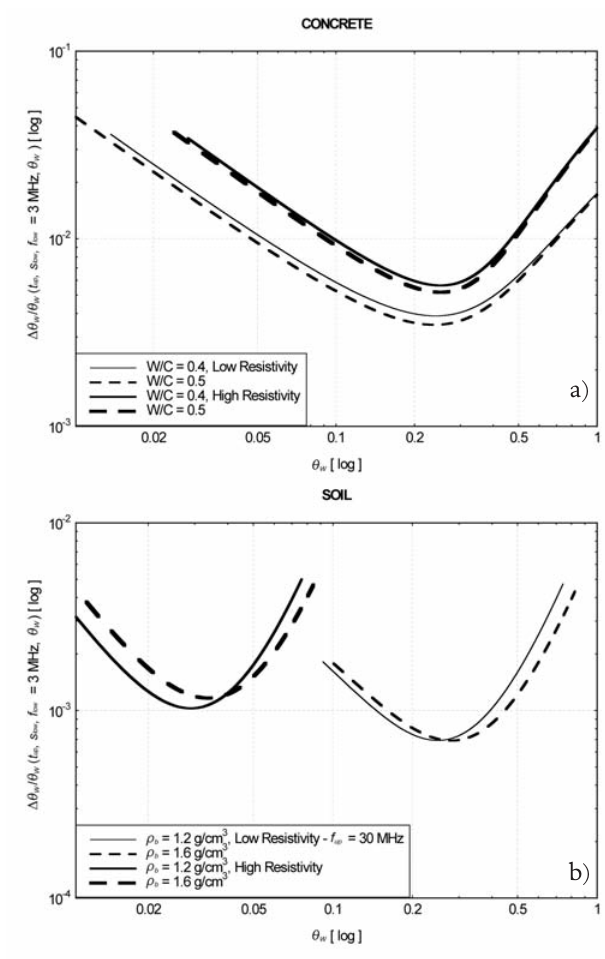
Figure 5. Operating conditions are described in the captions of Figures 1 and 3. The Like-Bode diagrams of inaccuracy D i , s , f , (cid:0) v ) as a low,up low,up a function of volumetric water content i ,s ], with s = 1 ppt and s = 40 low up low up i W ! [ 0, i W, lim ] defined in Table 1, for both concrete (a) and soil